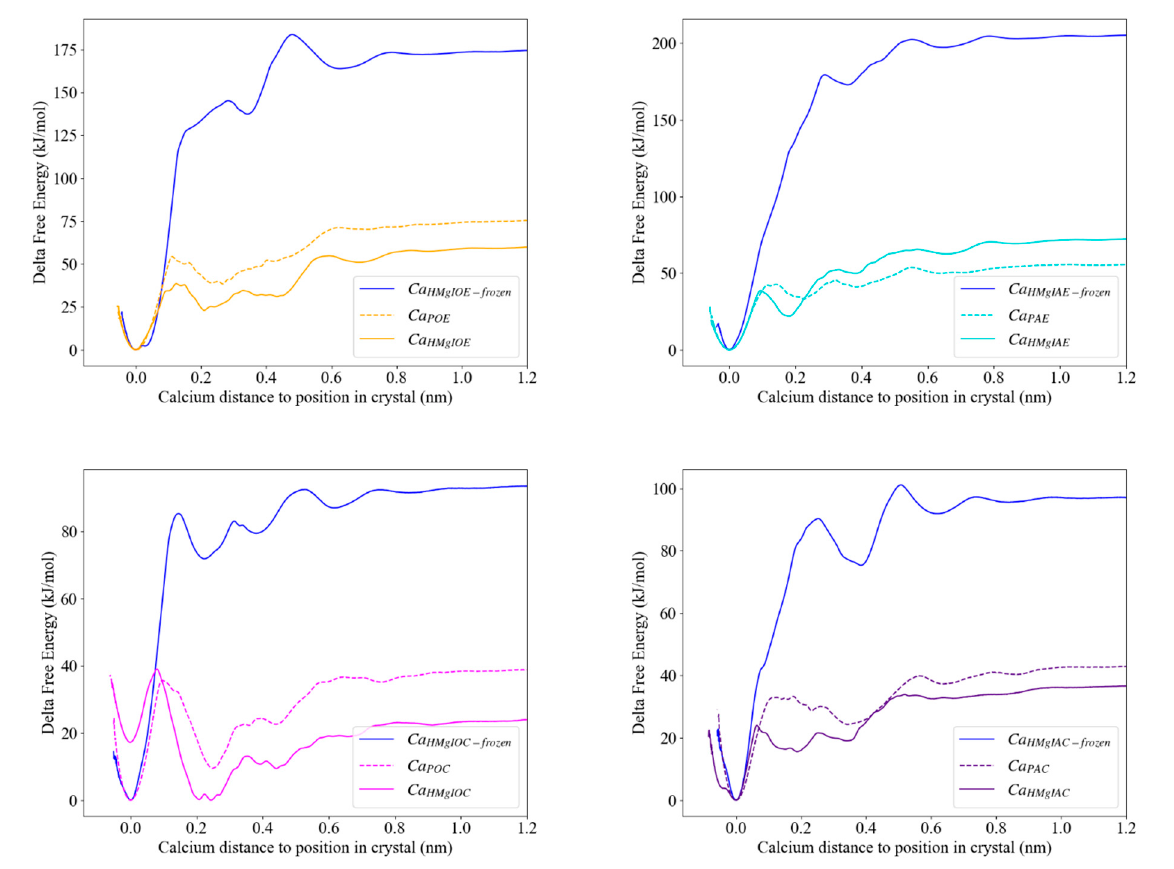
Figure 8. Free energy profiles of Ca 2+ extraction from PureI (dashed lines), HMgI (continuous line) and HMgI in which the island-carbonate molecules are frozen (continuous blue line).